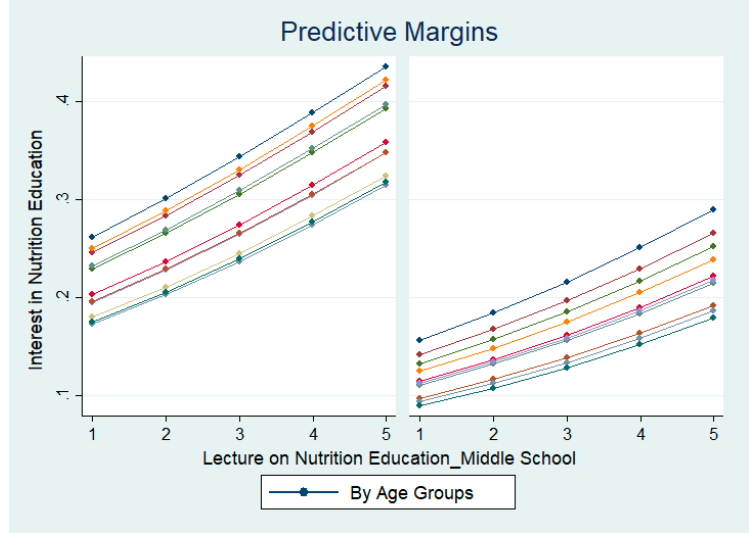
Figure 2. Effect of nutrition education instruction by instructors at middle school on interest in nutrition education, by gender and by age groups. Left shows the results of male respondents and right shows the results of female respondents. The 1–5 scales reflect the degree of the respondents’ experiences. 1 = strongly agree, 2 = agree a little, 3 = neither agree nor disagree, 4 = disagree a little, and 5 = strongly disagree. Table 4. Ordered logistic regression on the effects of nutrition education on having nutritionally balanced